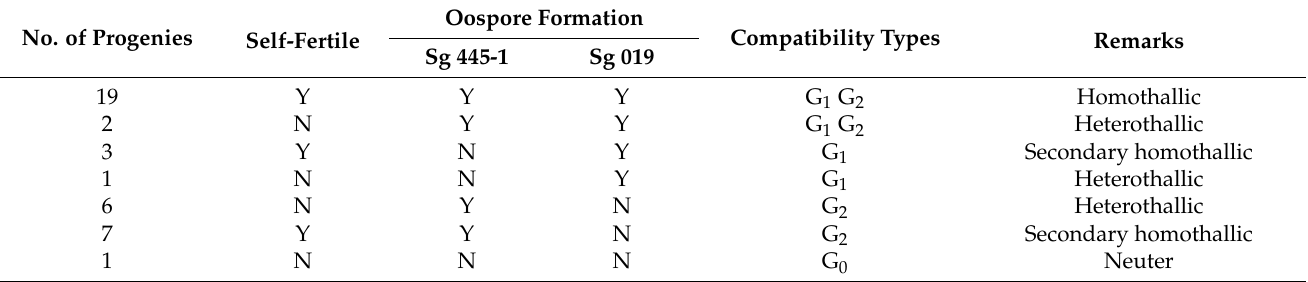
Table 5. Summary of determination of sexual compatibility types of F 1 populations based on oospore formation with Sg 445, Mat -1(G 1 ) and Sg 019, Mat -2 (G 2